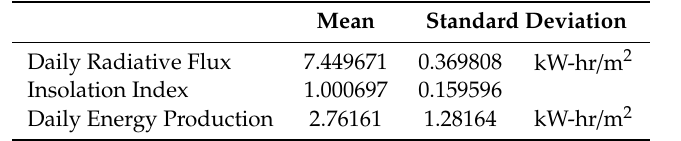
Table 2. Solar irradiation data [24].